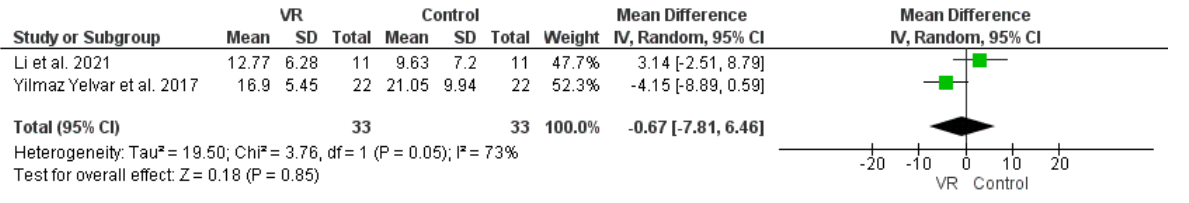
Figure 7. Effect of VR and control intervention on ODI outcome. Green squares represent mean difference for each study, while black rhombus represents the aggregated average of the mean differences.